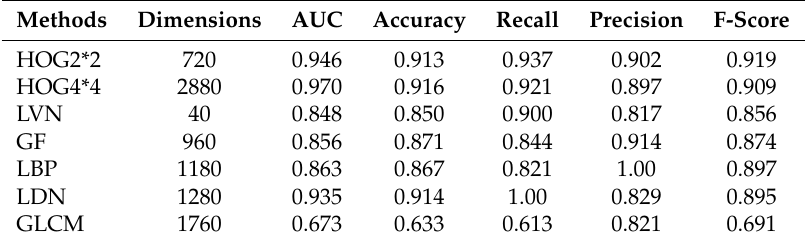
Table 3. The performance of the proposed method when concatenating the feature vectors of the 20 infrared images of each